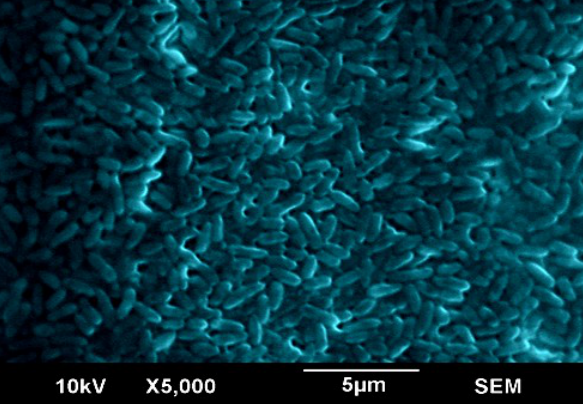
Figure 1. Colored scanning electron micrograph illustrating the appearance of P. aeruginosa CCIN34519 biofilm on polystyrene substratum